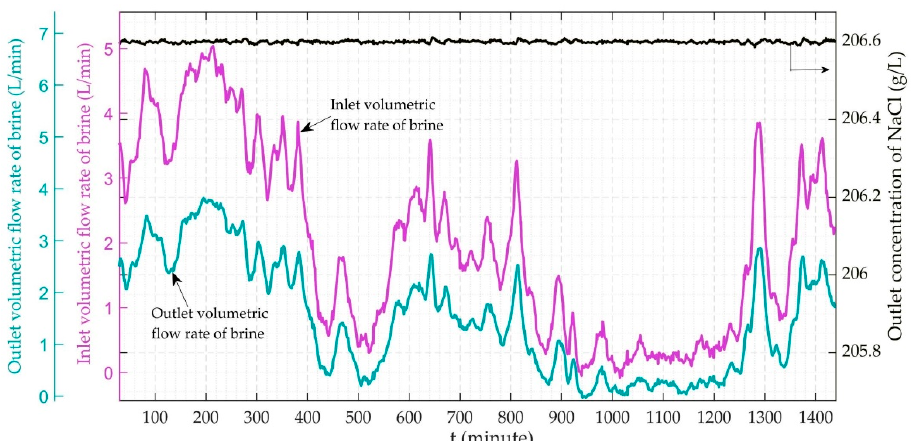
Figure 11. Simulated ramp rate profile of current density over a whole day.